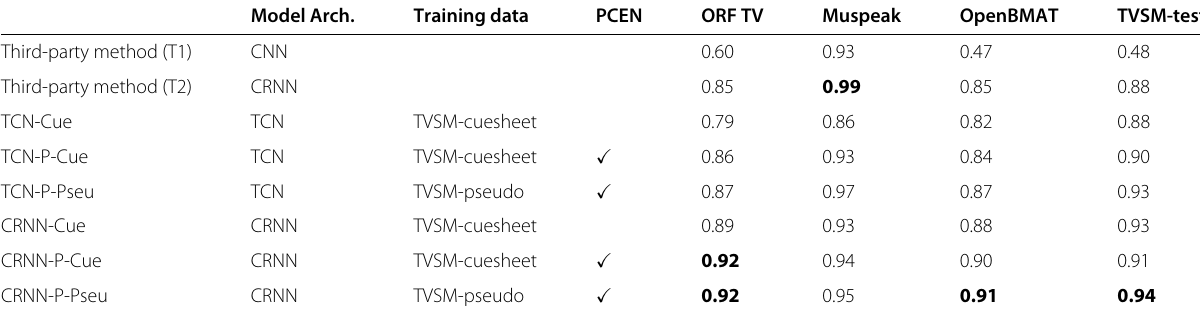
Table 5 F -measures for segment-level evaluation on music detection Model